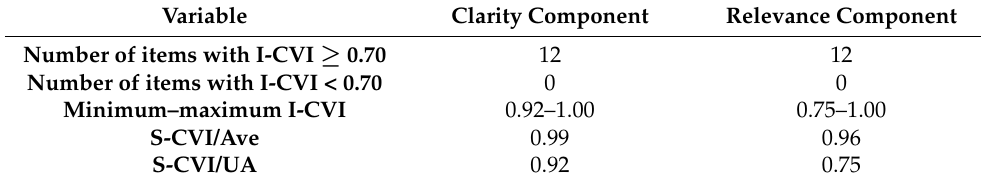
Table 3. Content validity assessment of the Arabic FRQ.